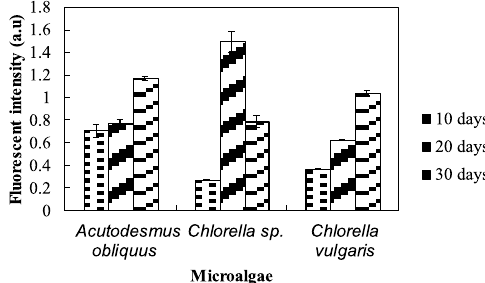
Fig. 3. Nile red staining results of